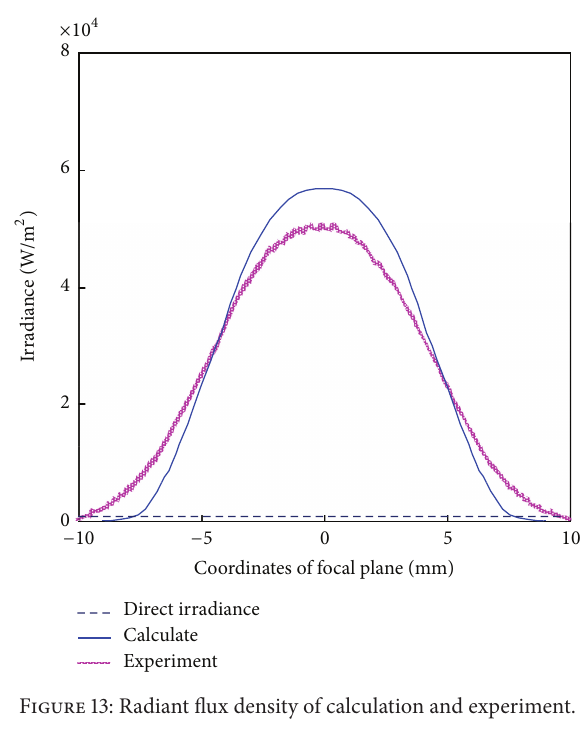
Figure 13: Radiant flux density of calculation and experiment.